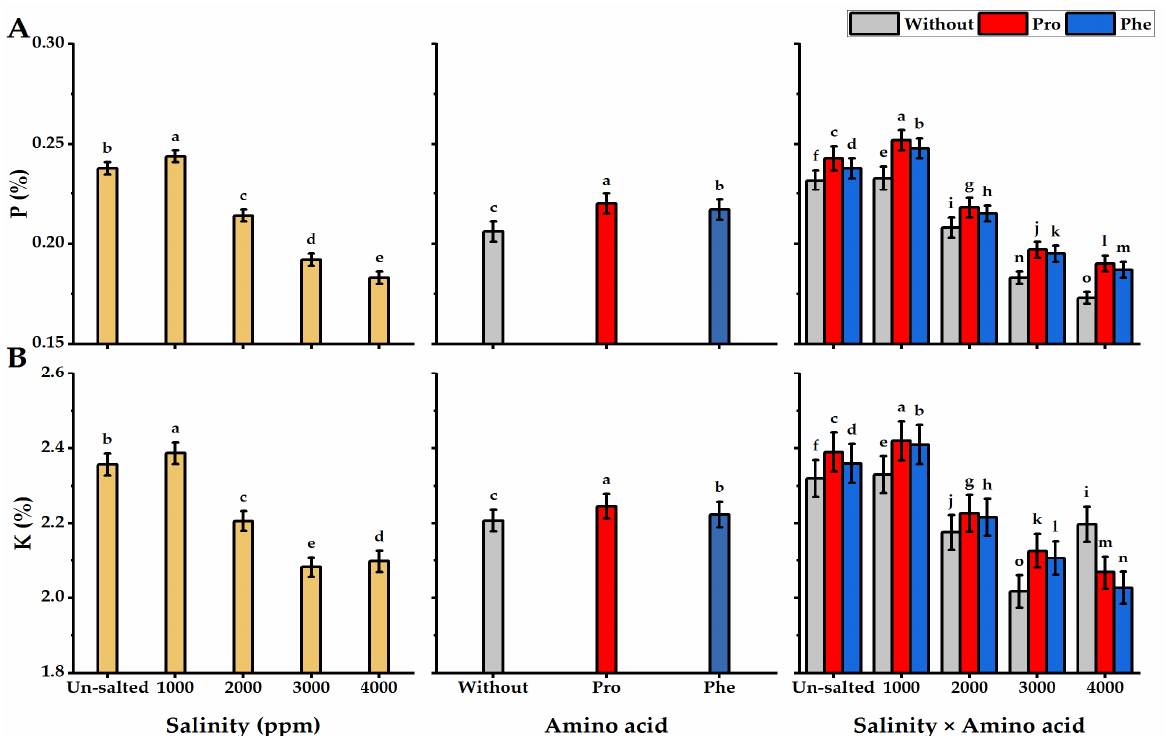
Figure 8. Influence of exogenous spray treatments of proline (Pro) or phenylalanine (Phe) on ( A ) phosphorus (P) and ( B ) potassium (K) content of moringa leaves cultivated under different levels of salinity. Data are mean value ± SE. Bars with different letters are significantly different at p ≤ 0.05 level.